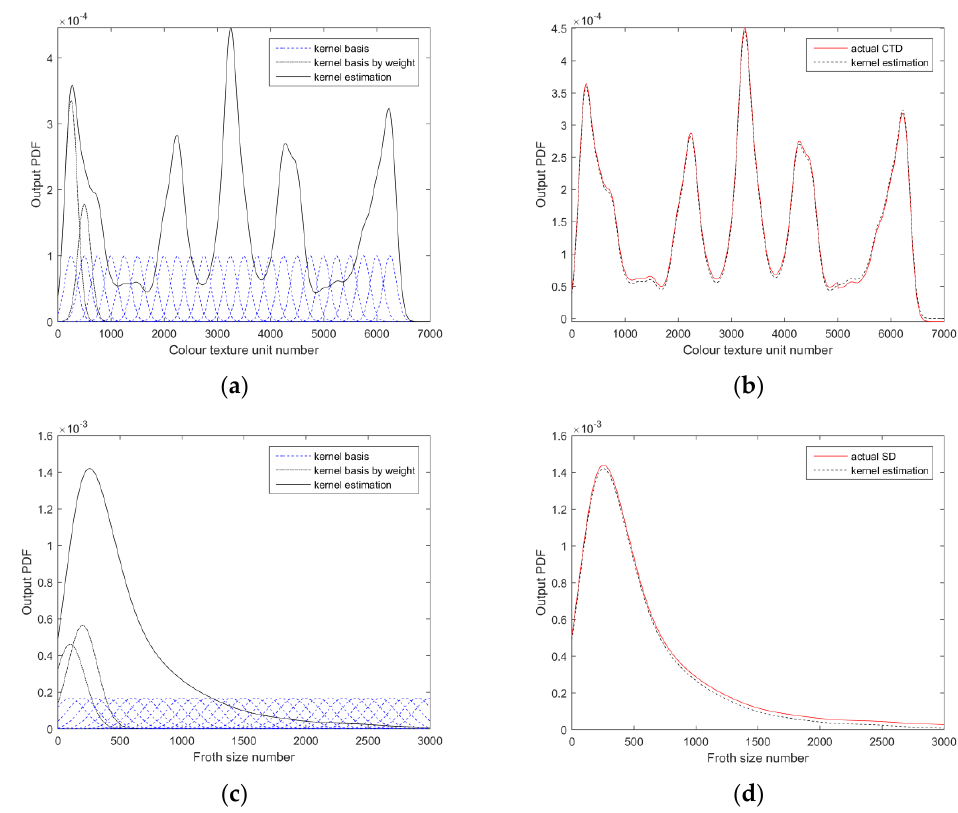
Figure 8. ( a ) Gaussian kernel density estimation of froth color texture unit distribution. ( b ) Gaussian-kernel-based kernel density estimation method to estimate the actual color texture unit distribution. ( c ) Gaussian kernel density estimation of froth SD. ( d ) Gaussian-kernel-based kernel density estima- tion method to estimate the actual SD.